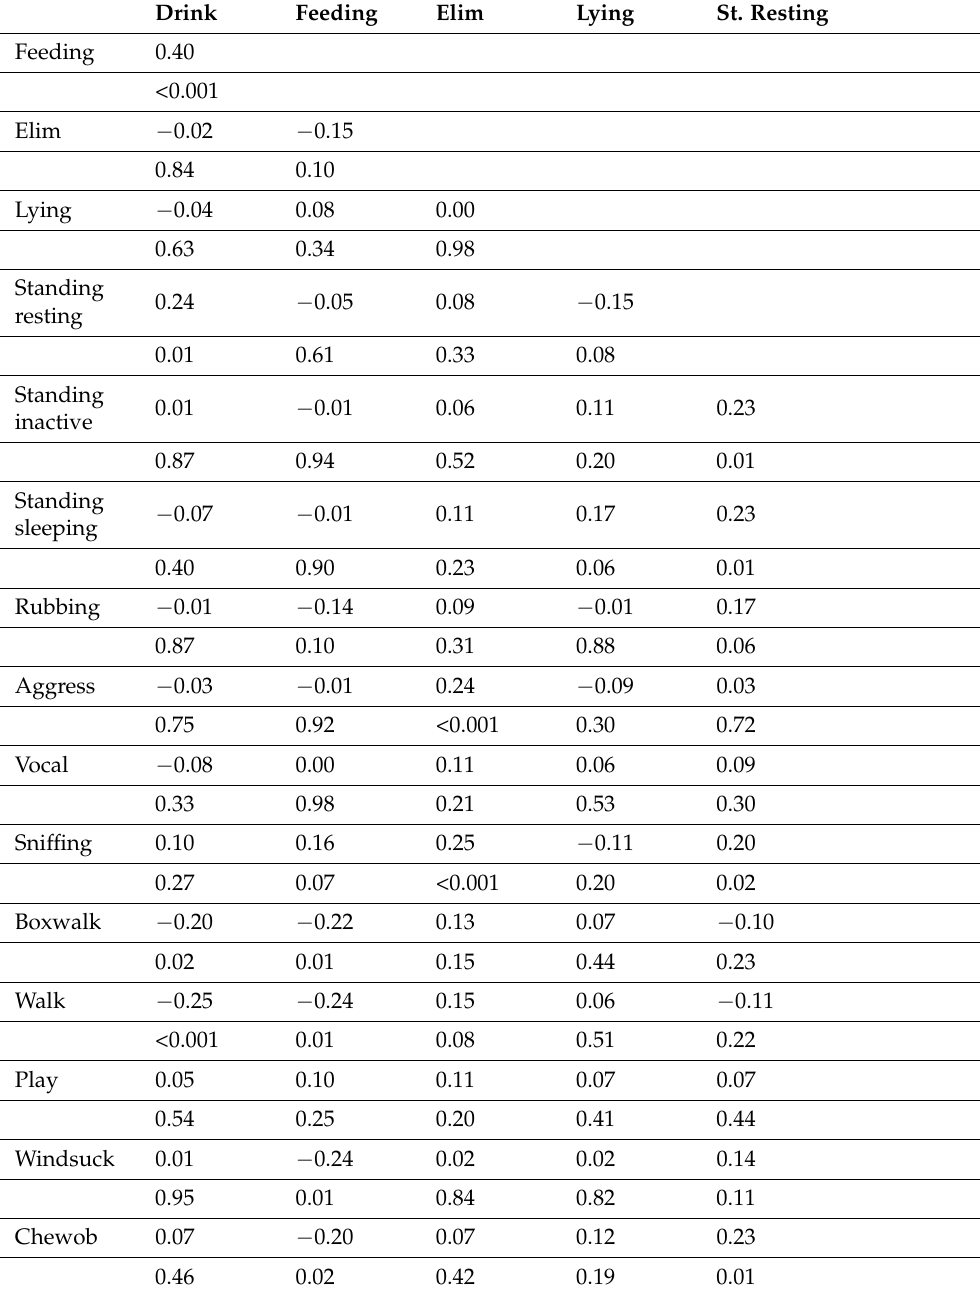
Table A2. Pearson correlation coefficients of transformed behaviour values (log 10 behaviour + 1, top value) and probability that the correlation is significant (bottom value). Drink Feeding Elim Lying St.